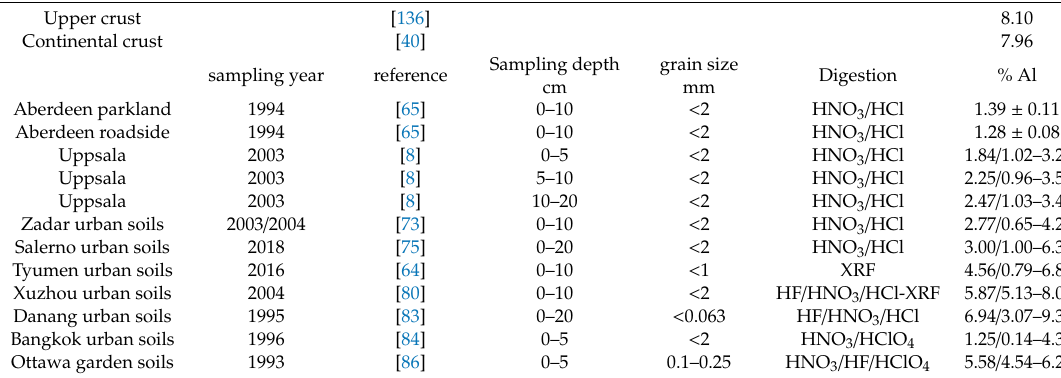
Table A1. Aluminum in urnan soils.